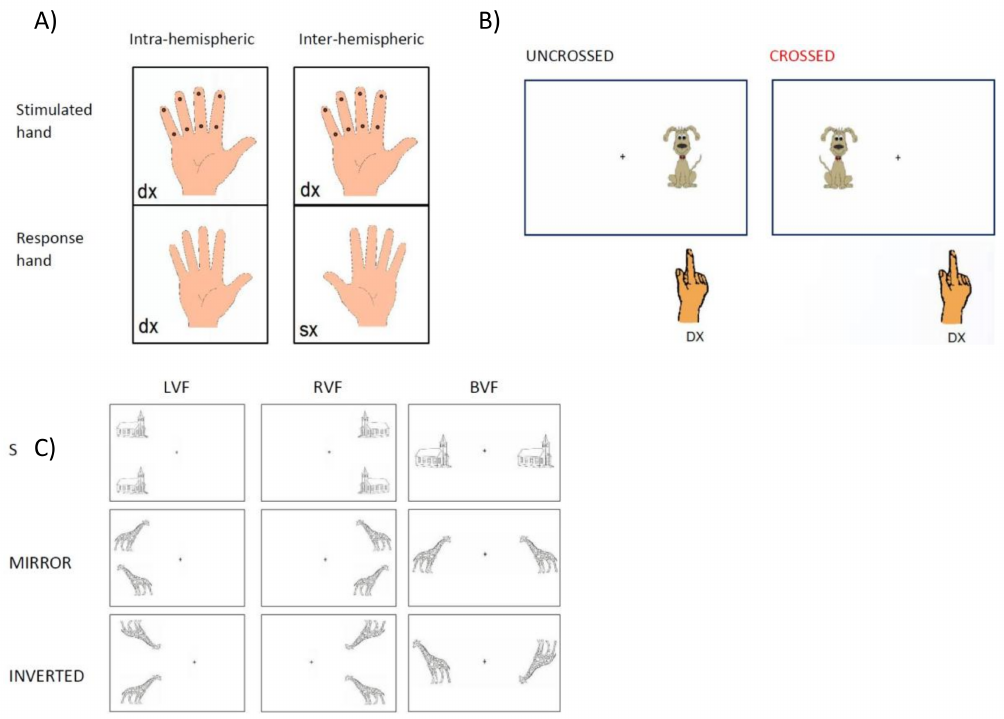
Figure 1. Three paradigms: ( A ) interhemispheric transfer of tactile information; ( B ) interhemispheric transfer of visual information (crossed-uncrossed differences, CUD); ( C ) same-different orientation judgment